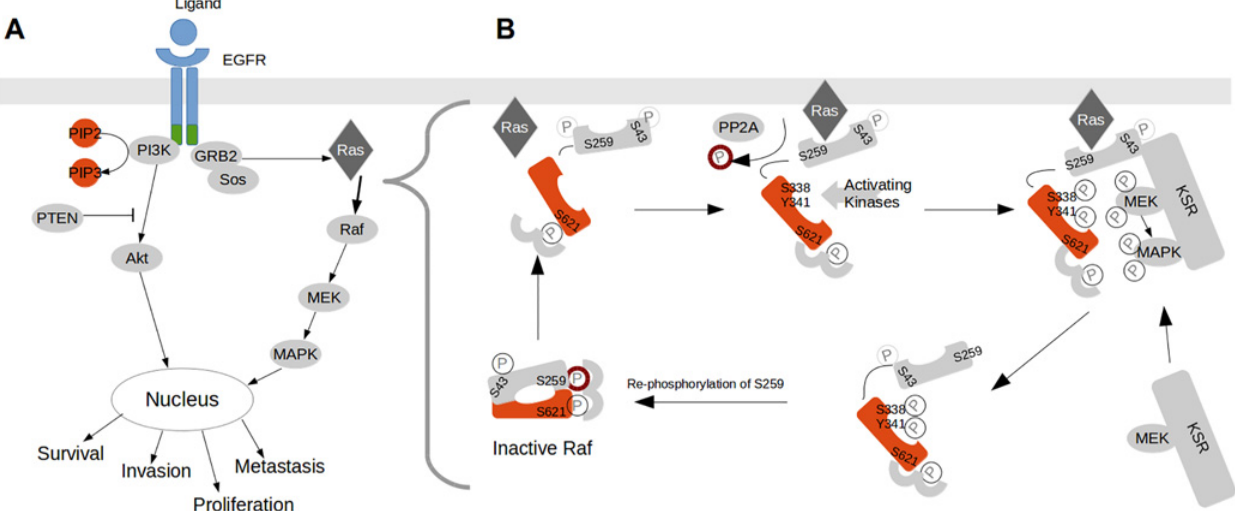
Fig 1. Comparison of linear and systems representation of Raf regulation. A) Traditional (linear) representation of MAPK signaling [13]. B) Detailed regulatory mechanism of Raf regulation that takes into account the role of most Raf interaction partners.